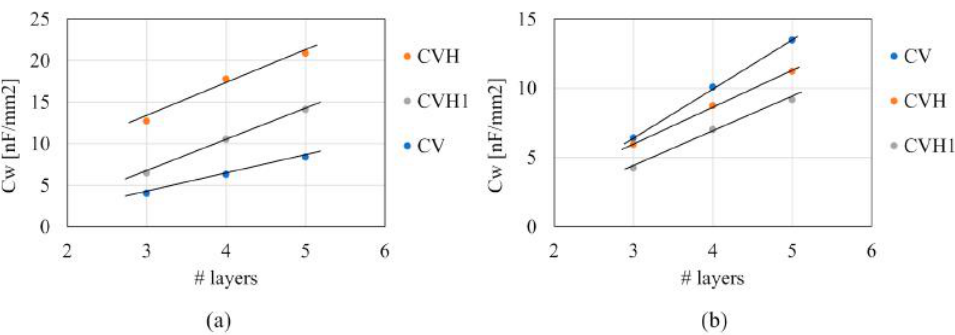
Figure 9. Capacitance vs. the number of wring layers: ( a ) S = W = T = 10 nm, H = 20 nm, ( b ) S = W = T = 25 nm, H = 7 nm.